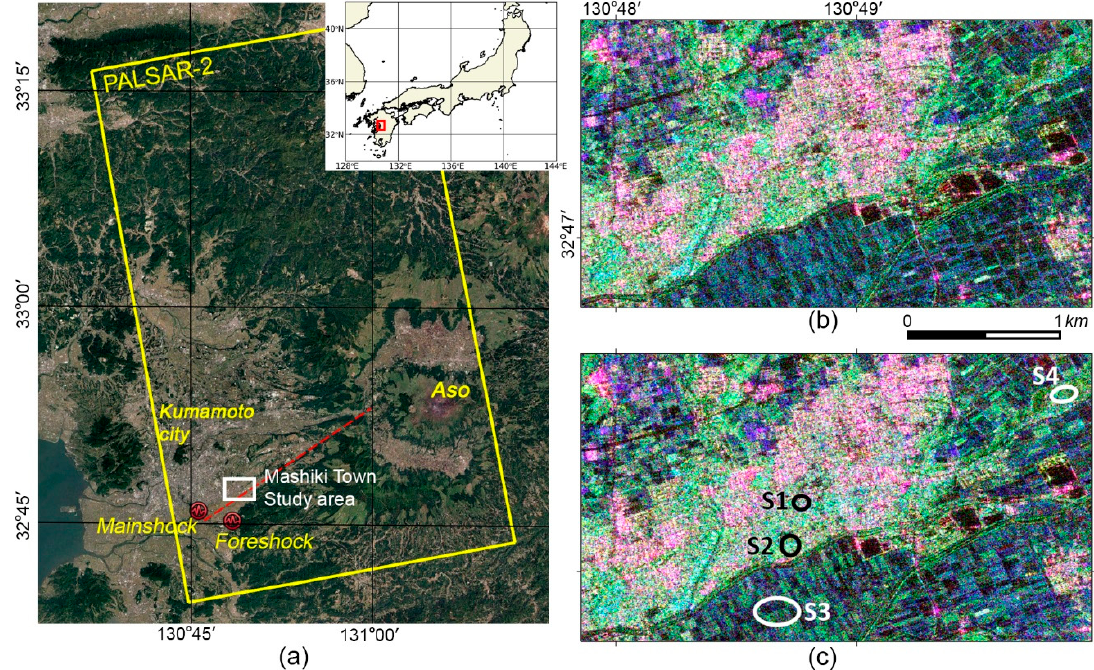
Figure 1. ( a ) ALOS-2 PALSAR-2 data coverage (yellow rectangle) and location of the Mashiki Town study area (white rectangle) marked on the Google Earth, and PALSAR-2 images (red: HH; green: HV; blue: VV) of the study area acquired ( b ) before (3 December 2015) and ( c ) after (21 April 2016) the earthquake. Locations of the foreshock and mainshock of the 2016 Kumamoto earthquake are also marked in ( a ). The red dashed line in ( a ) illustrates the approximated location of the Futagawa fault where the major damages are distributed. Four regions of interest (S1: collapsed buildings; S2: intact buildings; S3: intact croplands; and S4: intact forests) are indicated in ( c ).